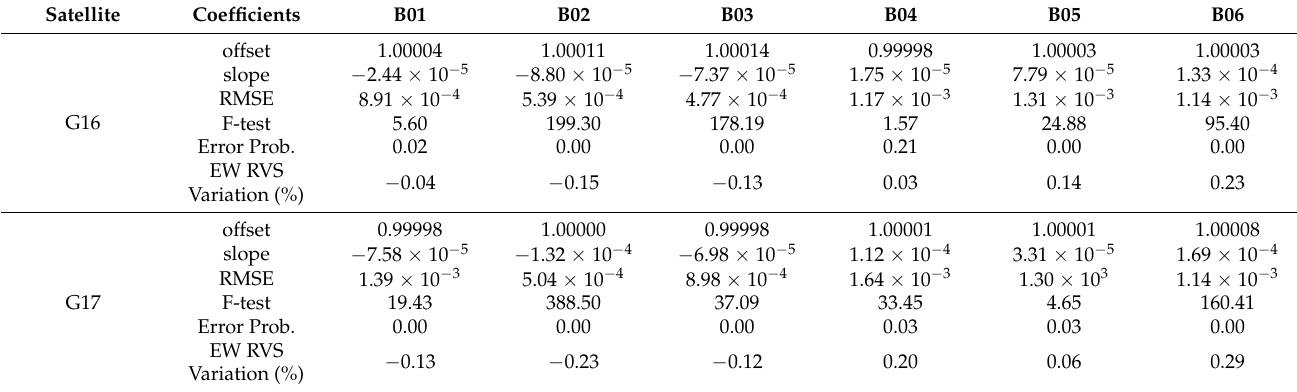
Table 4. Linear-fitting coefficients, root mean square error (RMSE), F-test value for the goodness-of-fit test, error probability, and EW RVS variation with scan angle ranging from − 8.7 ◦ to +8.7 ◦ for G16 and